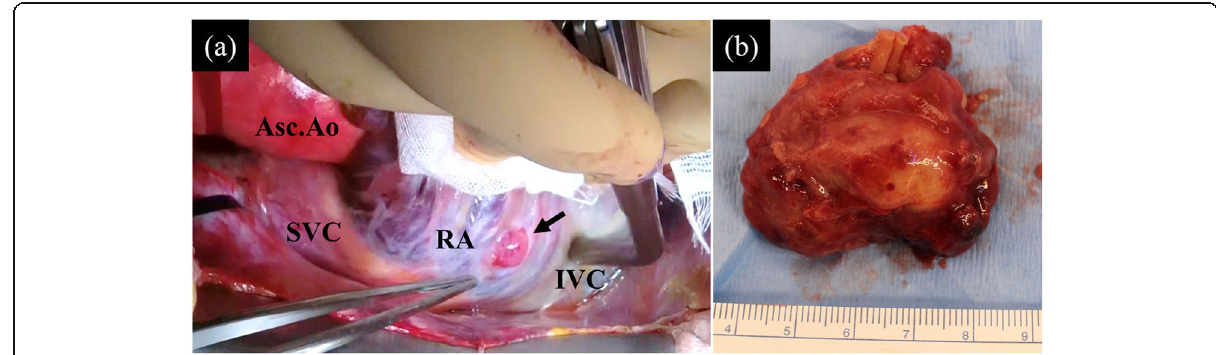
Fig. 2 a A small part of the mass (black arrow) was identified protruding though the right atrial free wall. b The 45-mm mass was soft and elastic with a smooth surface. Asc.Ao, ascending aorta; SVC, superior vena cava; RA, right atrium; IVC, inferior vena